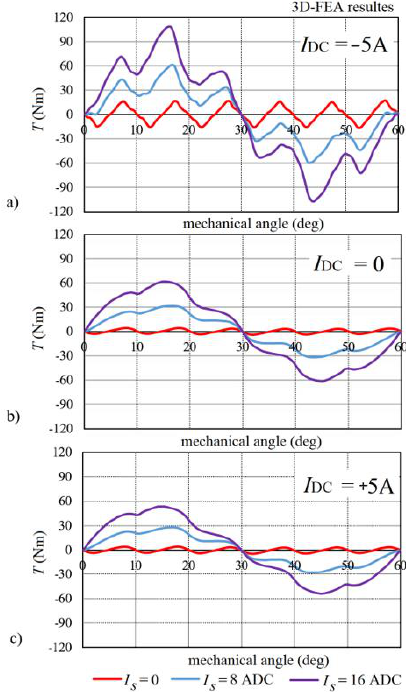
Figure 8. Electromagnetic torque waveforms versus rotor position under different stator currents for three I DC current excitations I DC − 5 A ( a ), I DC = 0 A ( b ) and I DC +5 A ( c ).